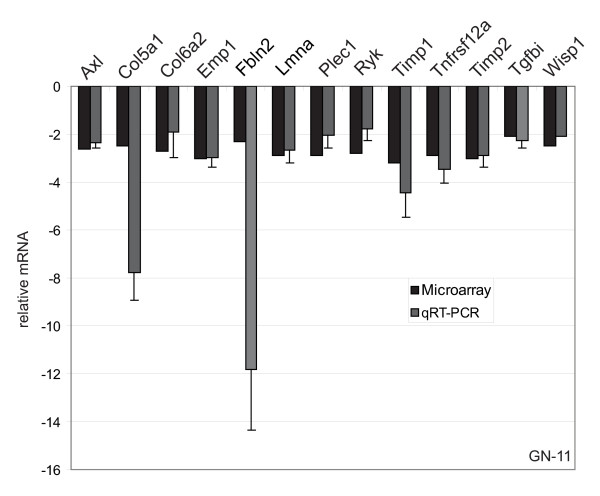
Microarray analysis validation for GN-11 neurons. Microarray data (Table 1 and Additional file 1) were validated by quantitative real-time polymerase chain reaction (qRT-PCR) performed in triplicate for 13 genes on two different RNA preparations from control pSUPER-empty or AP-2α low-expressing (α4-c) clones. The 18S or GAPDH housekeeping gene was used as an internal control to normalize the data. Microarray analysis and qRT-PCR fold changes are shown for each validated gene as average values. Bars represent ± standard deviations.